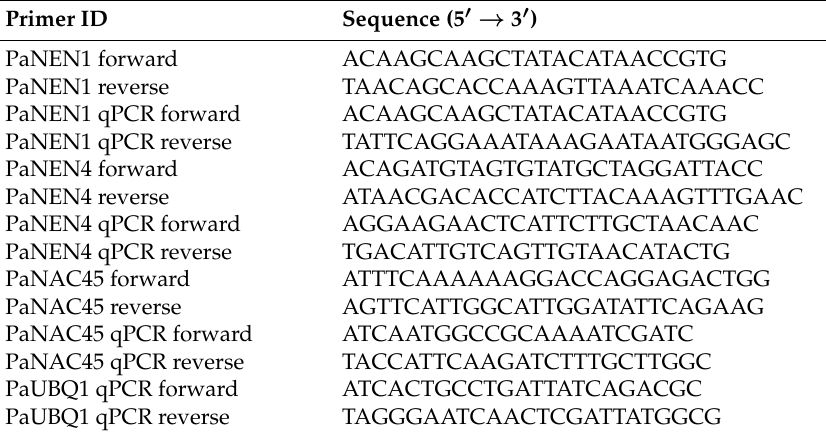
Table 1. Primers used in this